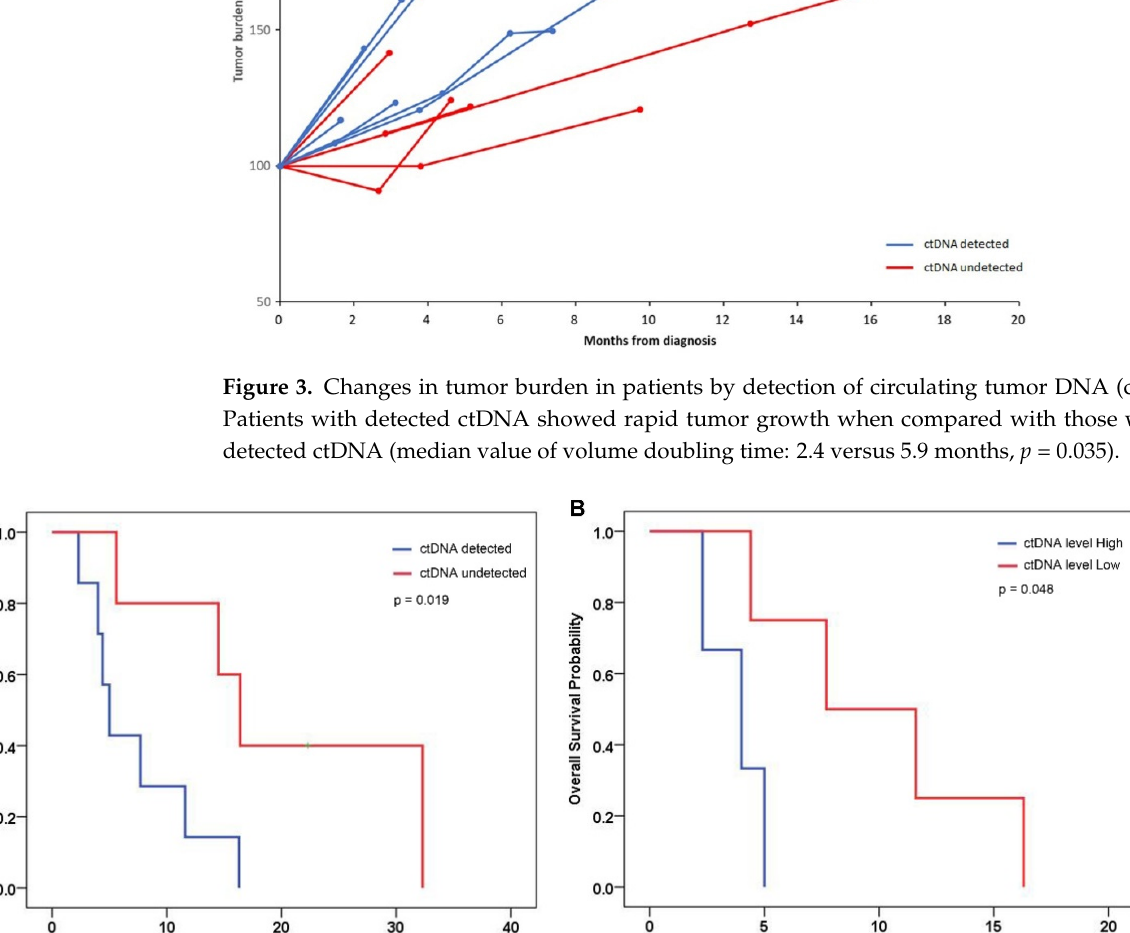
Figure 4. Kaplan–Meier curve for overall survival by ( A ) detection of circulating tumor DNA (ctDNA), and ( B ) ctDNA level. CtDNA levels were dichotomized by the median value.